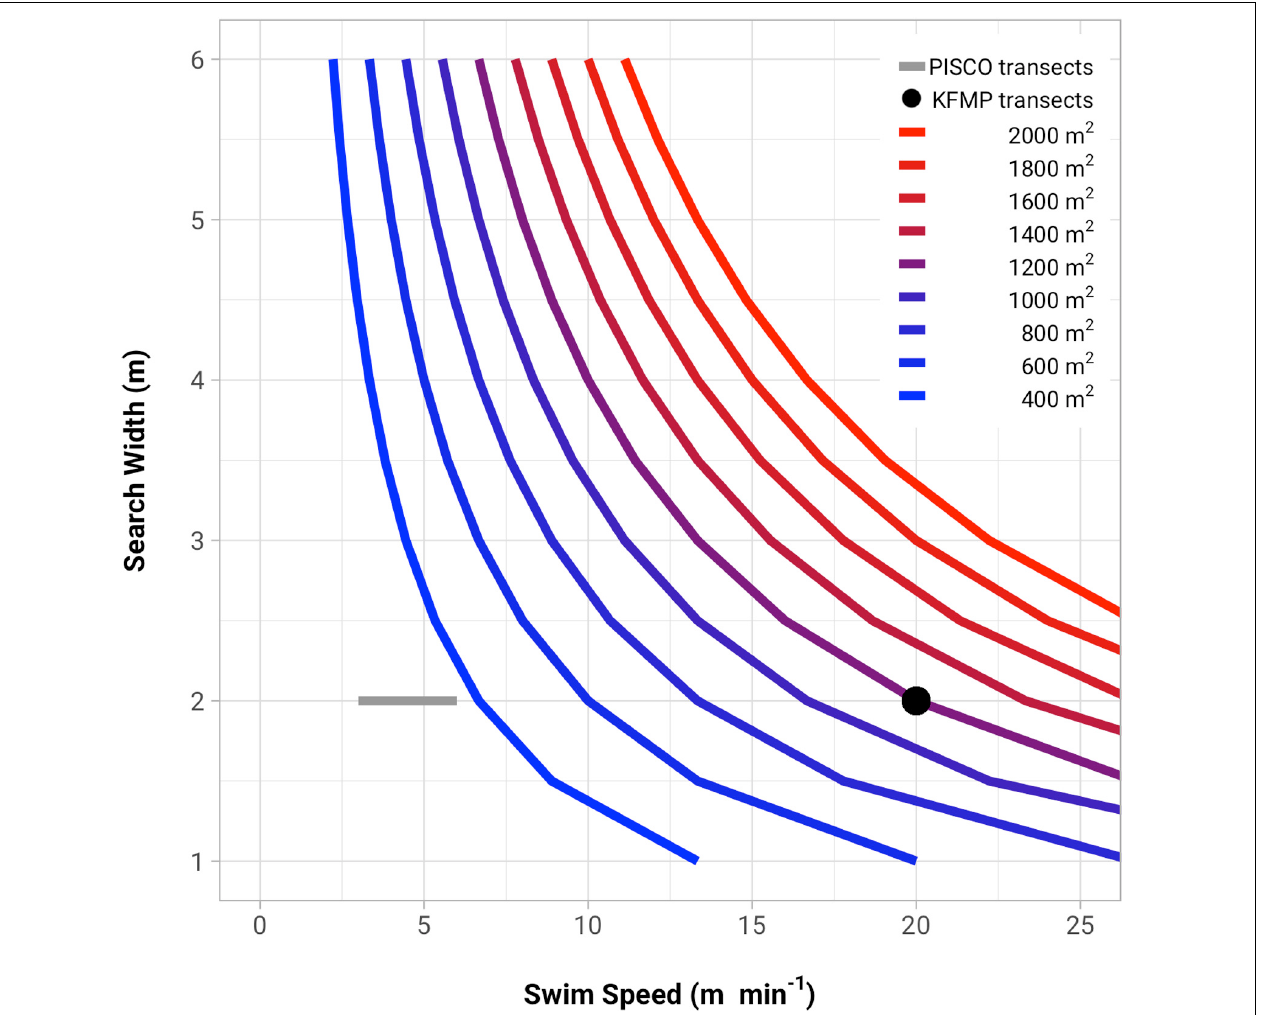
FIGURE 5 | Swimming speeds and search widths required to meet different assumptions about the total area being sampled in KFMP’s roving diver counts. Each curve represents a different assumed sampled area. The nominal transect width and swimming speed of PISCO and KFMP transect-based sampling are also plotted for